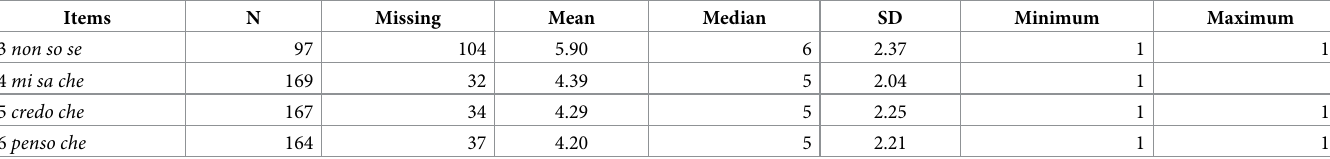
Table 3. The mean values of uncertainty assigned to sentences (3), (4), (5) and (6). Items N Missing